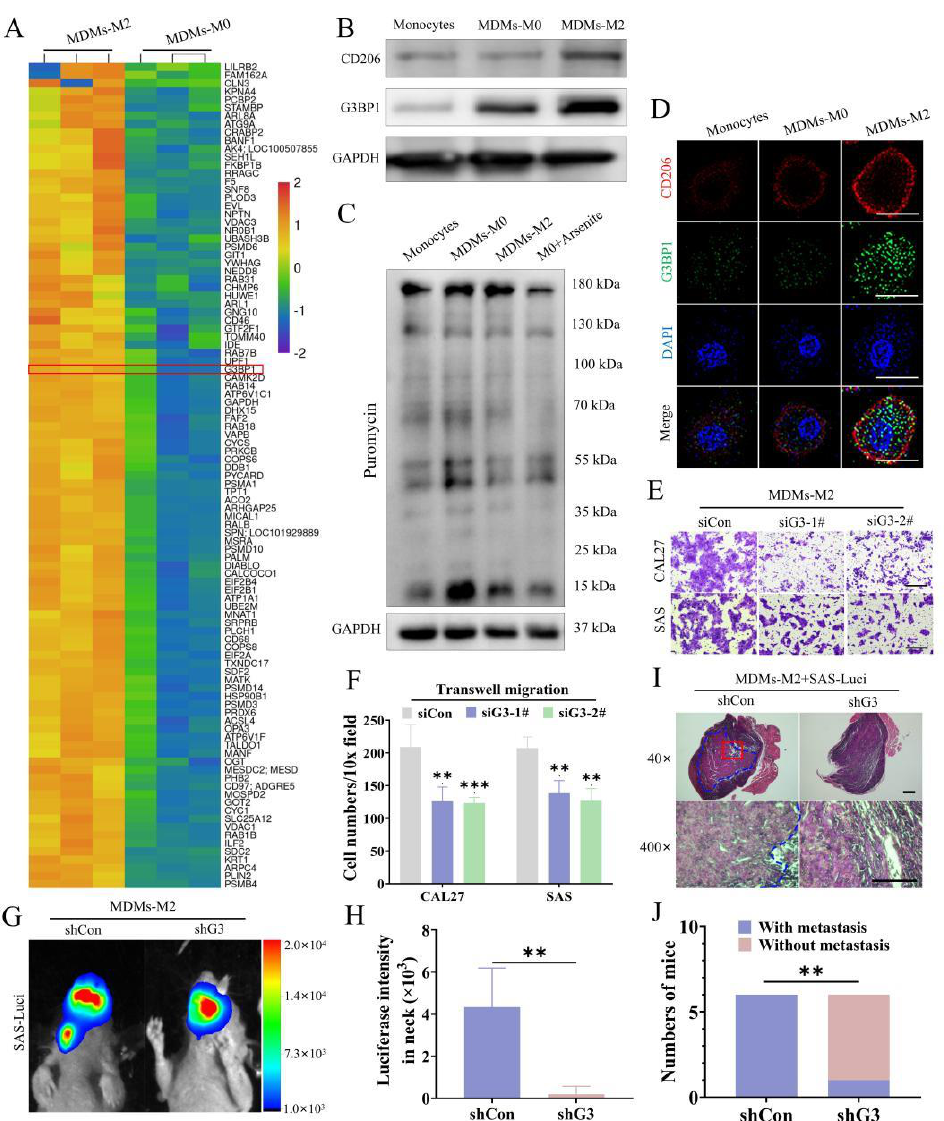
Figure 2. Increased SG formation in M2 TAMs promoted OSCC metastasis. ( A ) The data from heat map showed upregulated G3BP1 expression in MDMs-M2 compared with MDMs-M0 via Mass Spectrometry. ( B ) Western blot analysis demonstrated the upregulated protein expression of G3BP1 in MDMs-M2. ( C ) The indicated macrophages were incubated with puromycin (30 µg/mL) for 20 min before lysis, and followed by analysis of Western blot with a puromycin-specific antibody to detect the global translation levels. ( D ) IF images revealed increased SG in MDMs-M2. Scale bar, 10 μm. ( E , F ) Cell migration assays of CAL27 and SAS cells co-culturing with MDMs-M2 transfected with control or G3BP1 siRNA using Transwell inserts. Scale bar, 50 μm. ( G , H ) SAS cells stably expressing the luciferase and mixed with MDMs-M2 transfected with control or G3BP1 shRNA were injected into the tongue of BALB/c nude mice ( n = 6). Bioluminescence signals of metastasis tumor (neck lymph node) were quantified on 18 days after tumor transplant with an in vivo imaging sys- tem. ( I ) H&E staining of the neck lymph nodes from mice. Blue dotted lines: metastasis tumor le- sions. Scale bars, 100 μm. The enlarged pictures are placed on the bottom. Scale bars, 30 μm. ( J ) The numbers of mice with and without neck lymph nodes metastasis. All experiments were performed in triplicate, and the data were presented as the means ± SD. (**, p < 0.01; and ***, p < 0.001). We wondered if SG formation played a pivotal role in sustaining the protumor phe- notype of M2 TAMs. SG formation can be inhibited by depletion of G3BP1 (Figure S2A – C). Inhibition of SG formation downregulated CD206 expression in MDMs-M2 (Figure